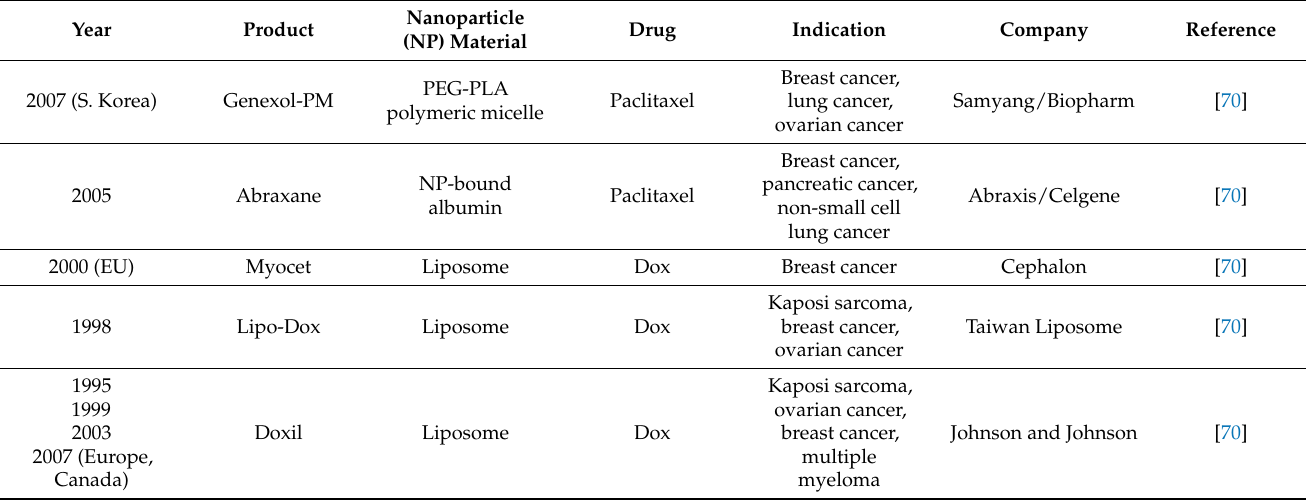
Table 3. Approved breast cancer drug therapies via parenteral route based on nanotechnology.